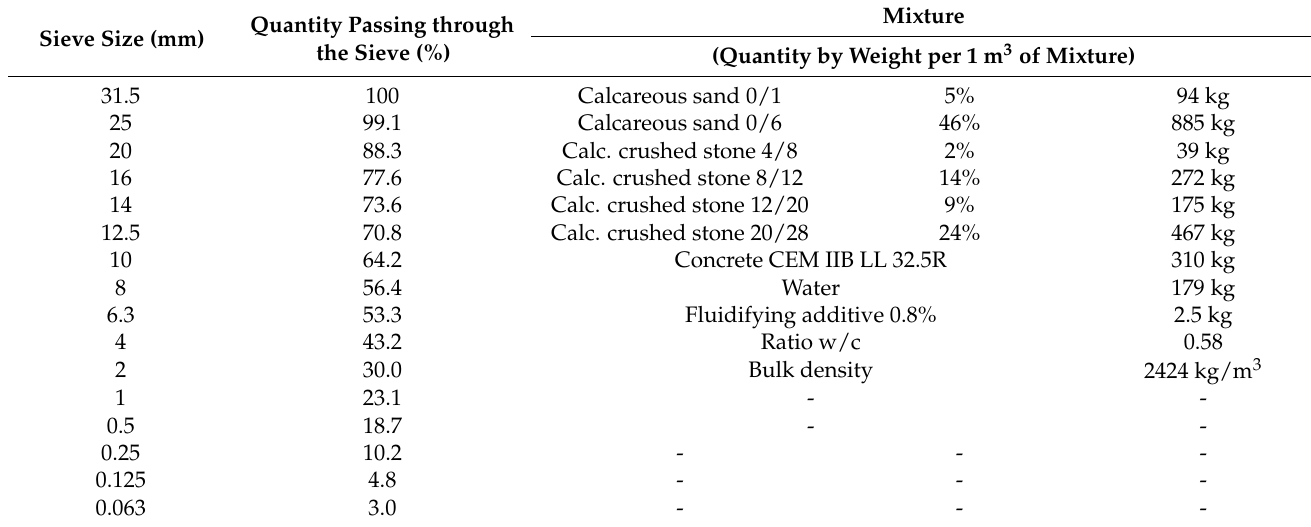
Table 2. Aggregate mixture with calcareous crushed stone. On the left side, the quantity passing through the sieve expressed in percentage of the calcareous crushed stone and the sieve size used; on the right side, the component used for the mixture. Sieve Size (mm)